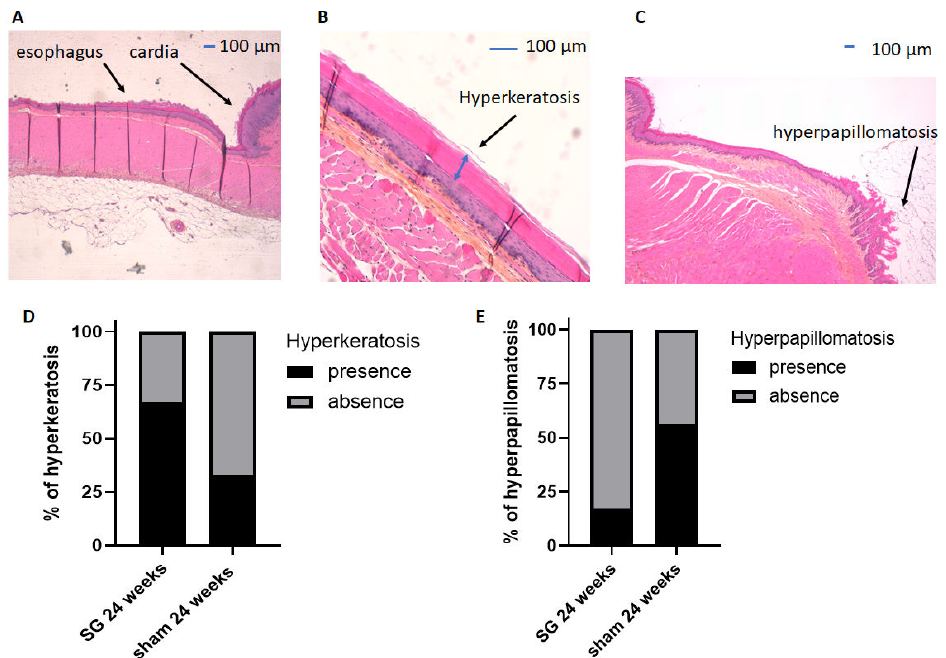
Figure 2. Analyses of HES staining of esophageal mucosa and comparison of the two groups of rats. Representative histology of healthy esophageal mucosa ( A ), esophageal hyperkeratosis (EHK) ( B ), and esophageal hyperpapillomatosis (EHP) ( C ). Comparison of the percentages of EHK ( D ) and EHP ( E ) after surgery between the two groups. SG: sleeve gastrectomy. All values are expressed as percentages, and comparisons were performed using Fisher’s exact